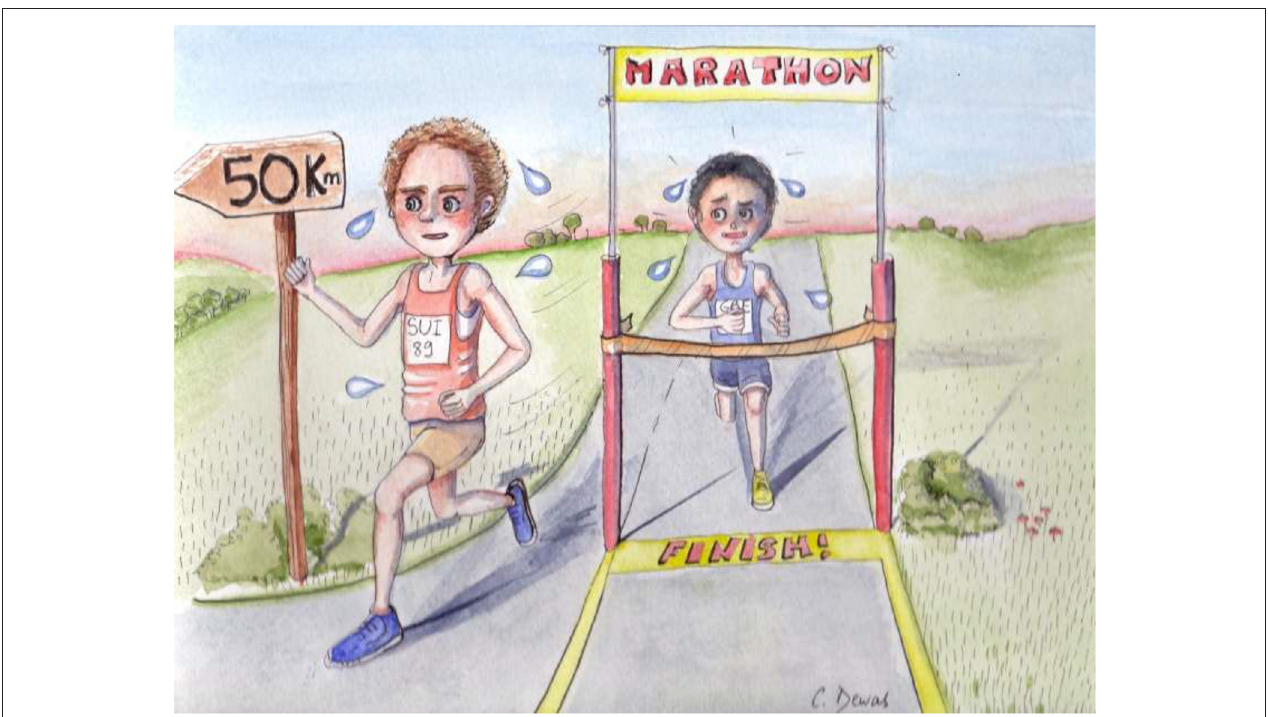
FIGURE 1 | A 50-km ultra-marathon is the shortest ultra-marathon. Figure by Céline